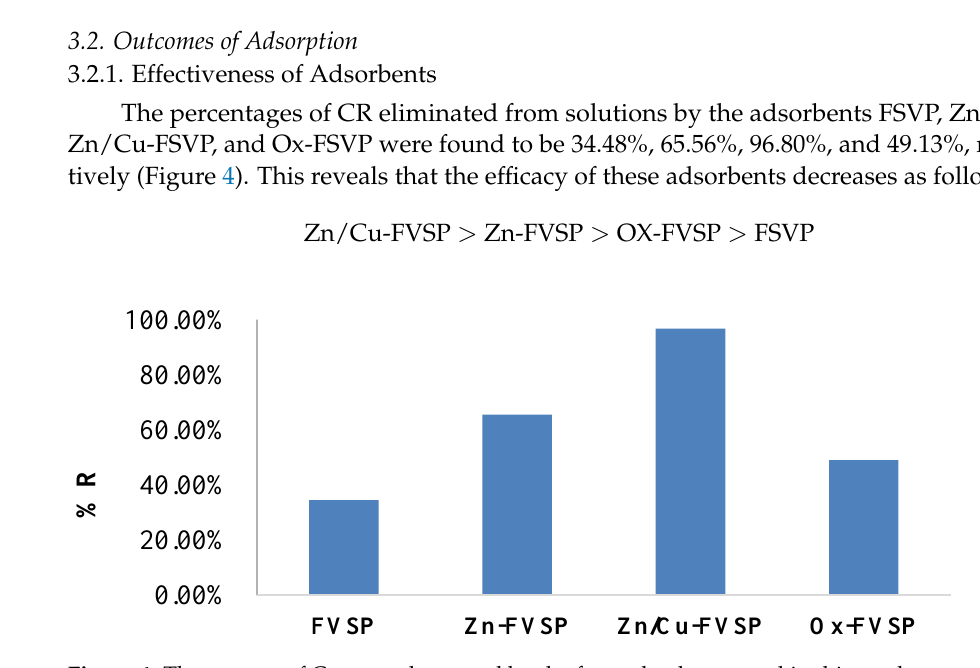
Figure 4. The percent of Congo red removal by the four adsorbents used in this work.